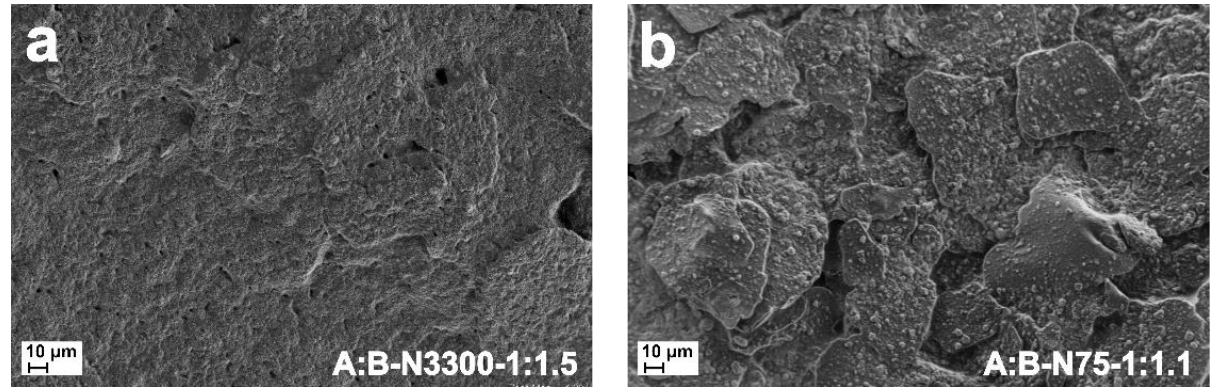
Figure 12. SEM micrographs of two TISS paints with ( a ) binder completely covering the flakes (A:B-